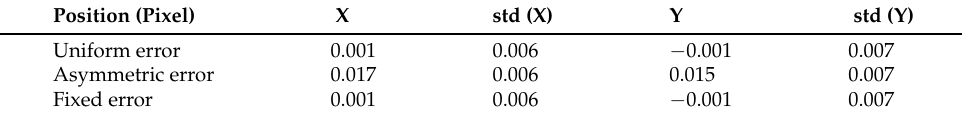
Table 4. Errors of mean position measurement by uniform, asymmetric, and fixed integral samplers.